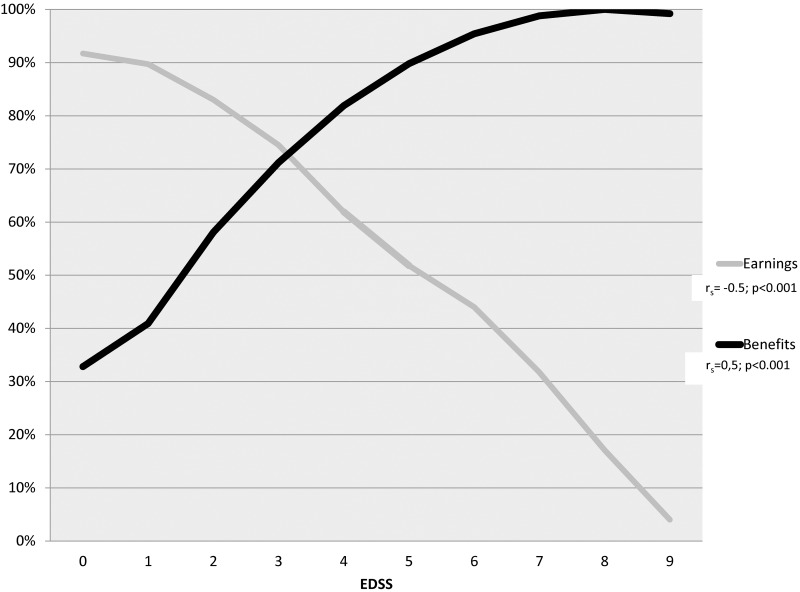
Percentages of MS patients who had earnings and got benefits, by different disability levels.